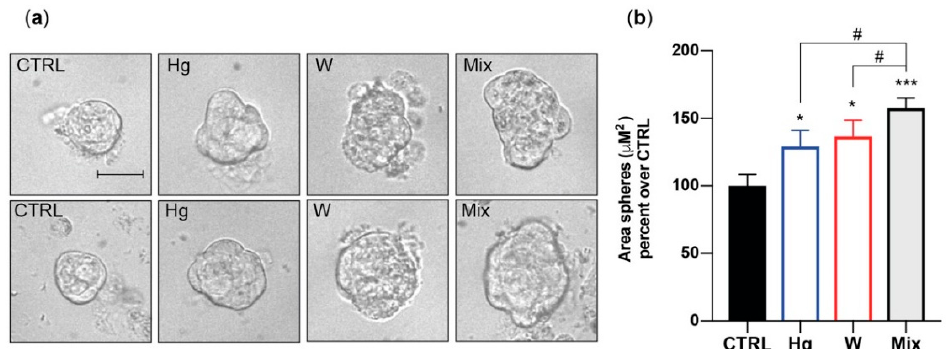
Figure 3. Morphological changes induced by thyrosphere exposure to metals. ( a ) Representative phase-contrast images of thyrospheres grown for 8 days in standard medium (CTRL) or in medium with either 0.1 nM of HgCl 2 or 30 nM Na 2 WO 4 . The metal mixture (MIX) included the metal salts of Cu, Hg, Pd, W, and Zn at the concentration causing the greatest effect on BrdU incorporation (see Table 1). The scale bar is 30 µM. ( b ) Average values of the thyrosphere size calculated by measuring sphere areas using the Image J software from NIH. The bars indicate the mean ± standard error of the mean of three independent experiments (* p < 0.05, *** p < 0.001 (relative to CTRL), # p < 0.05 (Hg and W vs. Mix)). Represented data from ref. [56].